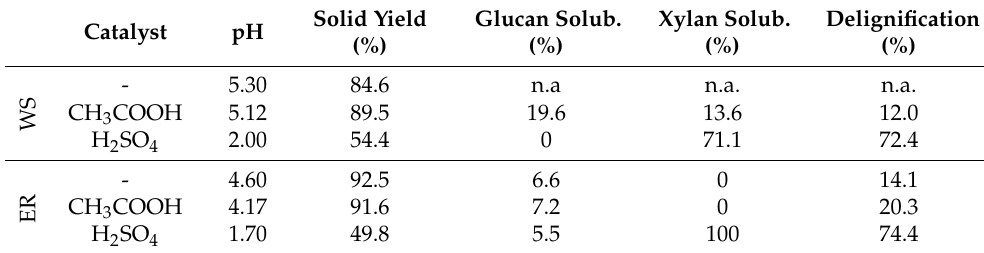
Table 4. Fractionation of wheat straw (WS) and eucalyptus residues (ER) biomass using ethanol- based organosolv process (no catalyst, acetic acid or sulphuric acid added as catalysts at 50 mM concentration, 140 ◦ C, 120